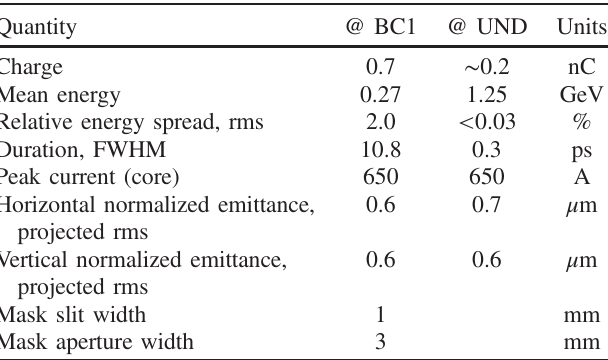
TABLE I. Electron beam parameters at the entrance of BC1 (whole bunch) and of the undulator (each beamlet) as from the tracking run. The mask geometry is also reported.